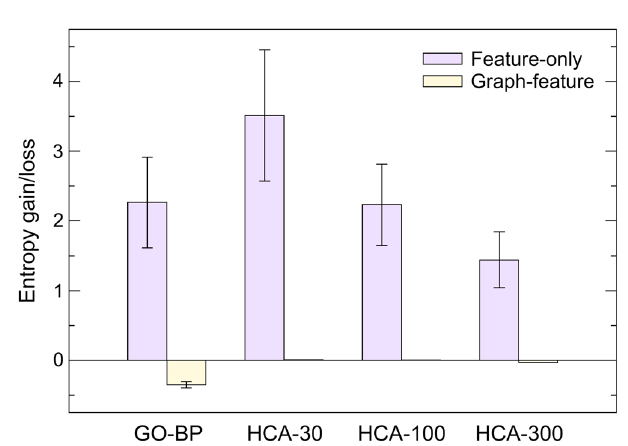
Fig. 4 Entropy gain/loss for different reduction schemes. Purple bars represent the Shannon entropy calculated using the feature matrix only, while yellow bars correspond to the graph-feature entropy computed using both feature and topological information of a graph. GO-BP requires that two incident nodes have a common biological process term to be assigned to the same cluster. HCA bars correspond to the clustering using GOGO similarities into 30, 100, and 300 clusters.